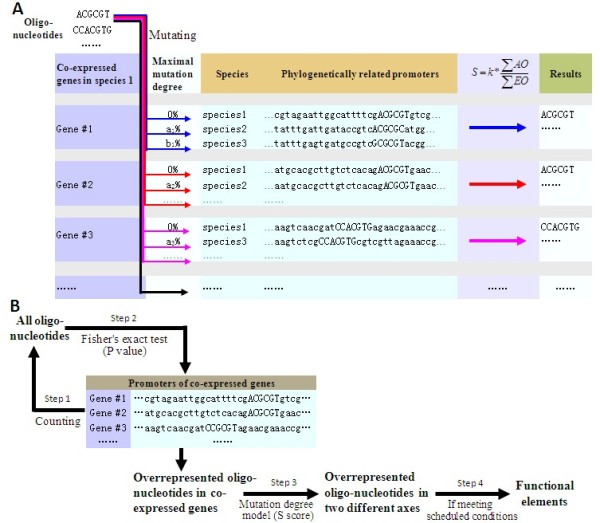
Illustrations for mutation degree model and OCW method. (A) Illustration of the mutation degree model. The phylogenetic promoter sequences of Gene#1, Gene#2 and Gene#3 etc. are highlighted in light blue. Mutation degrees between the promoter of species1 and its phylogenetic related promoters are denoted as a1%, b1%, etc. The data in the result column is only for demonstration. The co-expressed gene set highlighted in lavender belongs to Species1. (B) Flow chart of OCW. Step 1: All oligo-nucleotides presented in co-expressed genes are enumerated; Step 2: Fisher's exact test of the over-representation significance of the enumerated oligo-nucleotides; Step 3: Calculation of the conservation score of the elements resulted from step 2, the elements with S>1 are reported; Step 4: Reporting functional elements that meet the criteria assigned by user.